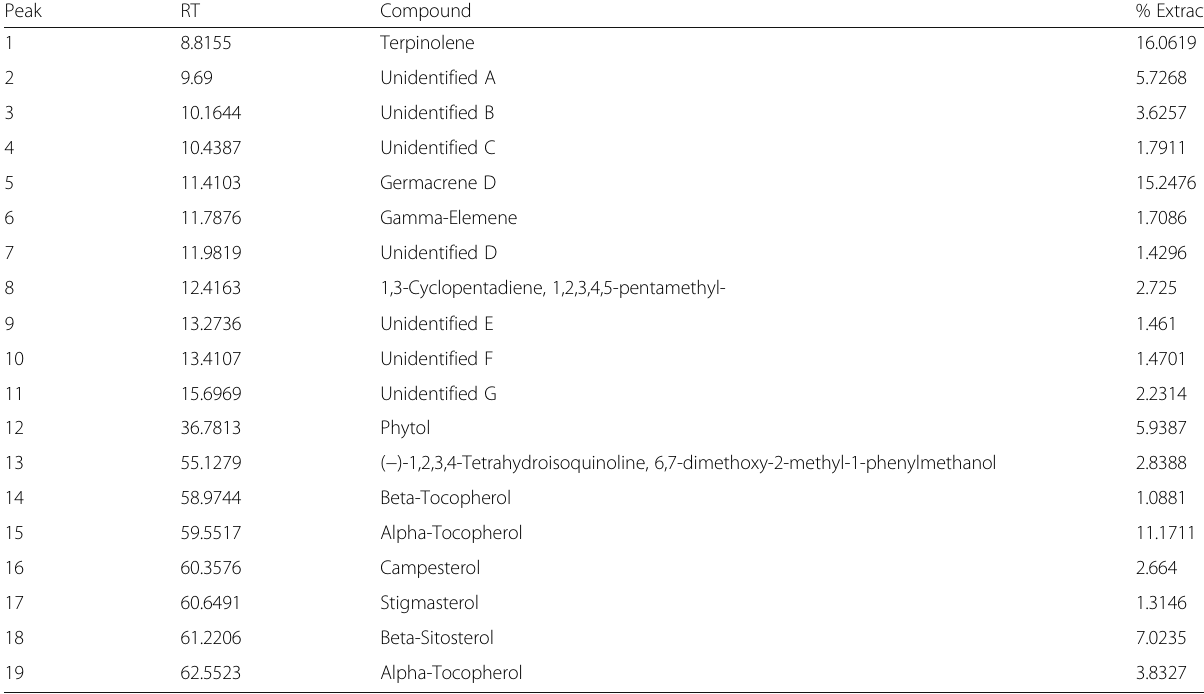
Table 1 The composition of the A. cherimola ethanolic leaf extract as elucidated by GC-MS. The major detected compounds were Terpinolene (16.0619%.), Germacrene D (15.2476%), and Alpha-Tocopherol (15.0038%). Other compounds remain unidentified